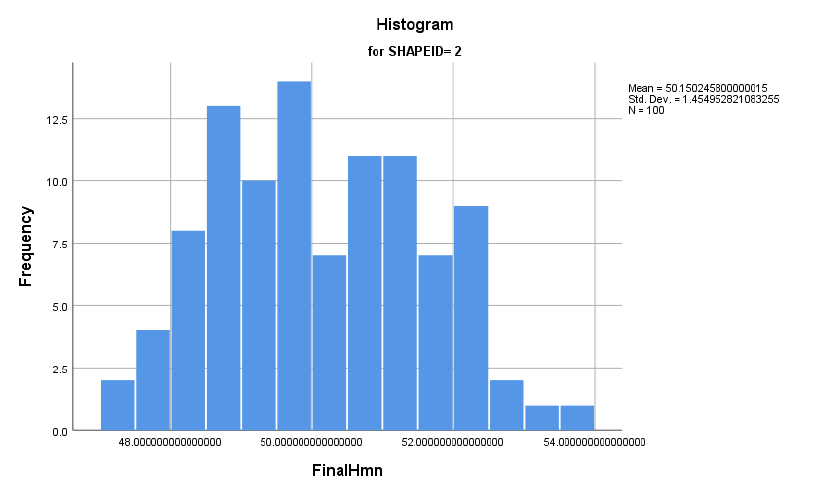
Figure A4. Grow height adjustment for 30 mm.